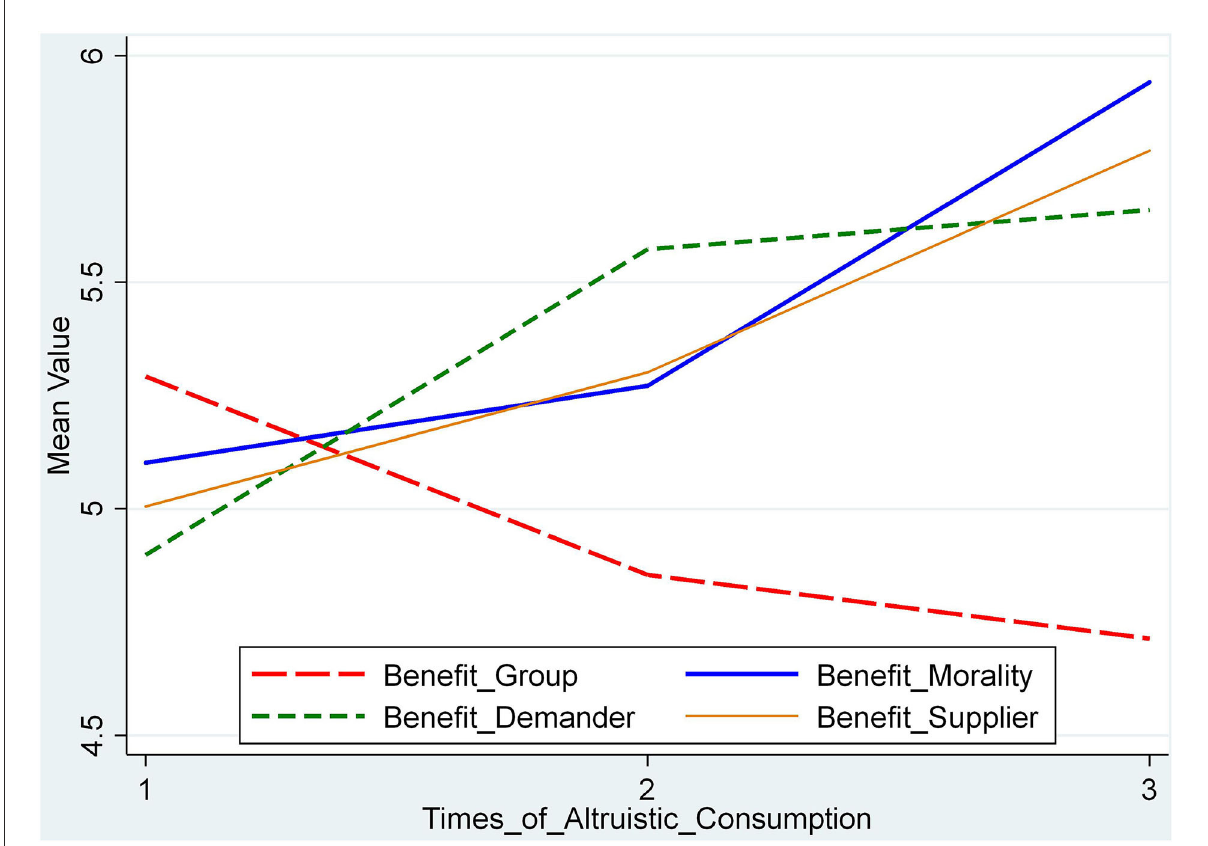
FIGURE2 Line chart of altruistic consumption motivation and the times of altruistic